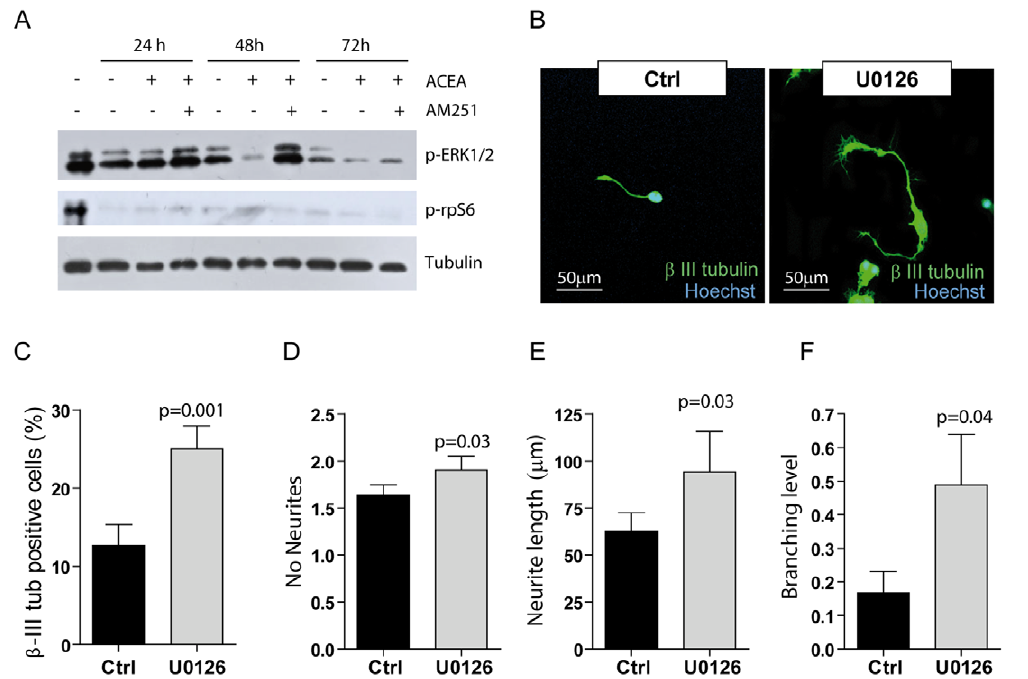
Figure 5. Reduced activity of ERK1/2 kinases promotes neuronal differentiation of NSCs. ( A ) Western blot analysis of the phosphorylation levels of ERK1/2 (p-ERK1/2) and rpS6 (p-rpS6), a downstream target of the mTOR pathway. Cell extracts (30 m g) from NSCs treated with or without ACEA (1 m M) and the CB 1 antagonist AM251 (1 m M) in the presence of 1% FBS for the indicated time were analysed. ( B ) Representative images of the immunofluorescence analysis of b -III tubulin in cells differentiated from NSCs after three days of culture in 1% FBS in the presence or absence of 10 m M U0126, a selective inhibitor of the ERK1/2 pathway. ( C ) The bar graph represents quantitative data (expressed in % of b -III tubulin-positive cells) of the immunofluorescence analysis of neuronal differentiation of NSCs cultured in differentiating condition in the presence or absence of 10 m M U0126. ( D–F ) Bar graphs represent quantitative data of morphometric analyses of the number ( D ), the length ( E ), and branching level of neurites ( F ) in cells treated as described in ( C ). Data represent the mean 6 SD of 6 experiments. Statistical analysis was performed using the paired t- test; the p value is indicated above the individual samples.